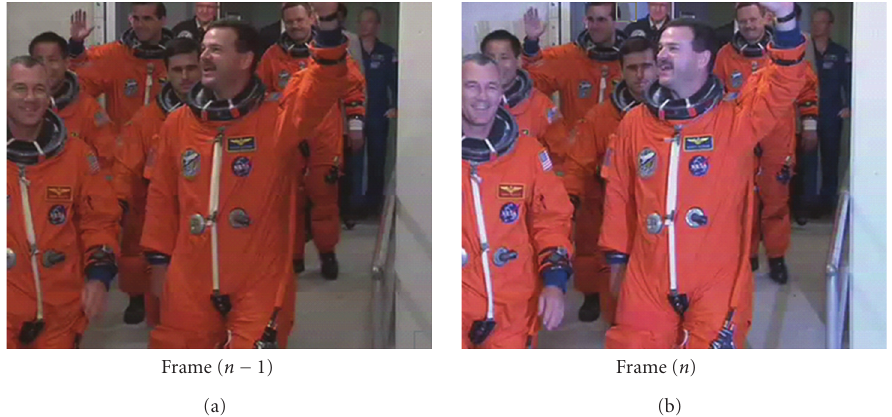
Figure 1: Luminance variation between consecutive frames due to flashing lights, with no scene change event.